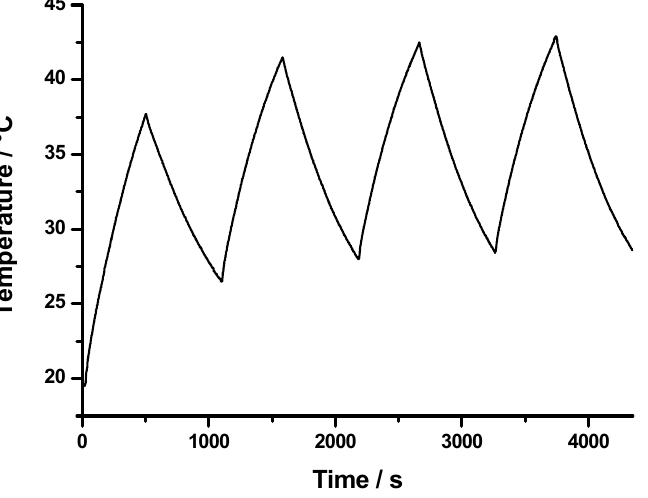
Figure 9. Stability measurement on a suspension of PMLABe NPs incorporating 10 wt% of Ni8C12 complex (C pol = 300 µg·mL − 1 ) over three heating cycles under 880 nm laser irradiation (3 W·cm − 2 ).